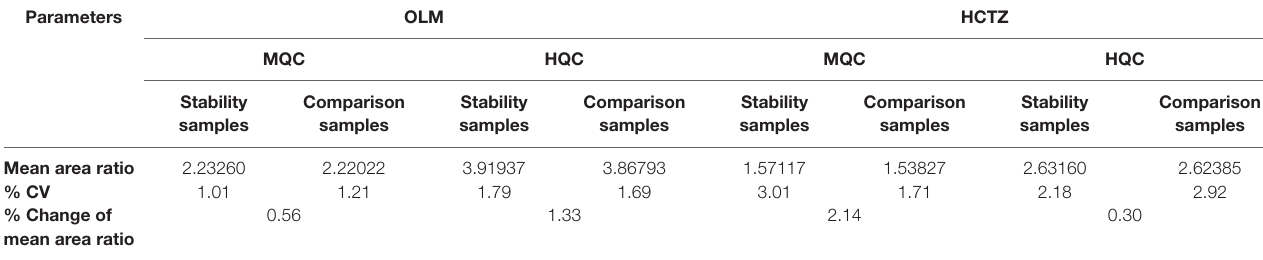
TABLE 6 | Blood Stability results. Parameters